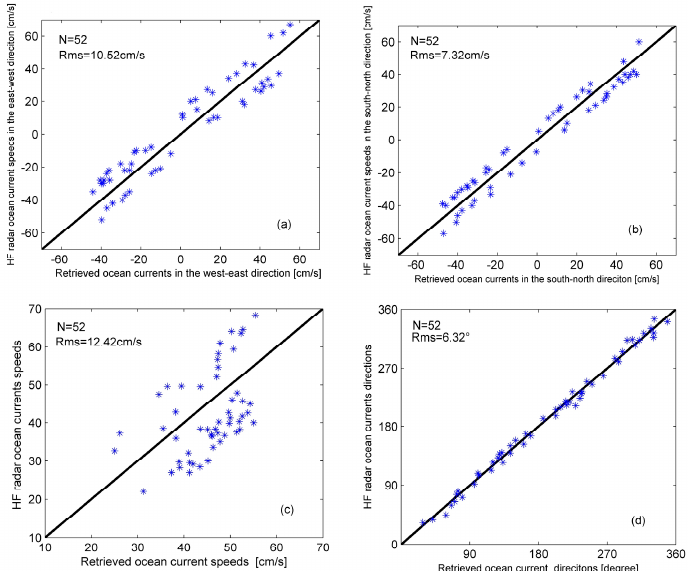
Figure 9. ( a ) Retrieved ocean surface current speeds in the east–west direction from empirical formulae given in Equations (7) and (8) versus HF radar measurements; ( b ) Retrieved sea current speeds of south–north direction from empirical formulae in Equations (7) and (8) versus HF radar measurements; ( c ) Synthetic current speeds in the east–west and south–north direction versus HF radar measurements; ( d ) Synthetic current directions versus HF radar